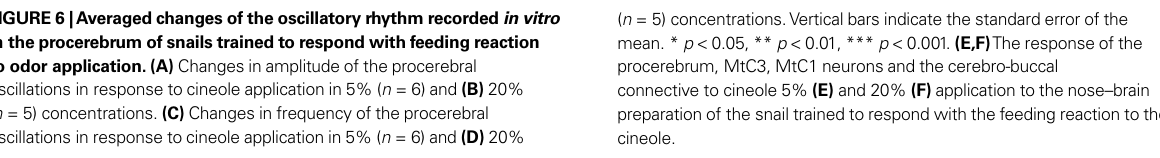
FIGURE 6 | Averaged changes of the oscillatory rhythm recorded in vitro in the procerebrum of snails trained to respond with feeding reaction to odor application. (A) Changes in amplitude of the procerebral oscillations in response to cineole application in 5% ( n = 6) and (B) 20% ( n = 5) concentrations. (C) Changes in frequency of the procerebral oscillations in response to cineole application in 5% ( n = 6) and (D) 20%